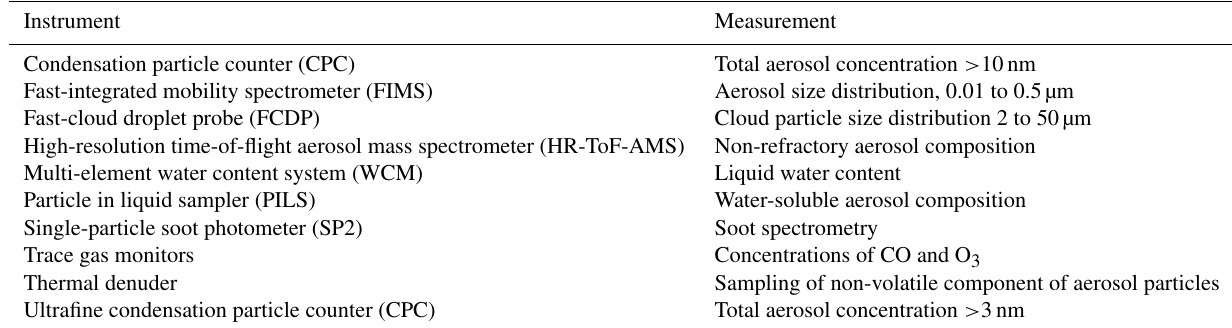
Table 1. Instrumentation deployed during the ACE-ENA that are used for data analysis in this study. All measurements were made at a frequency of 1Hz except for the HR-ToF-AMS, PILS, and thermal